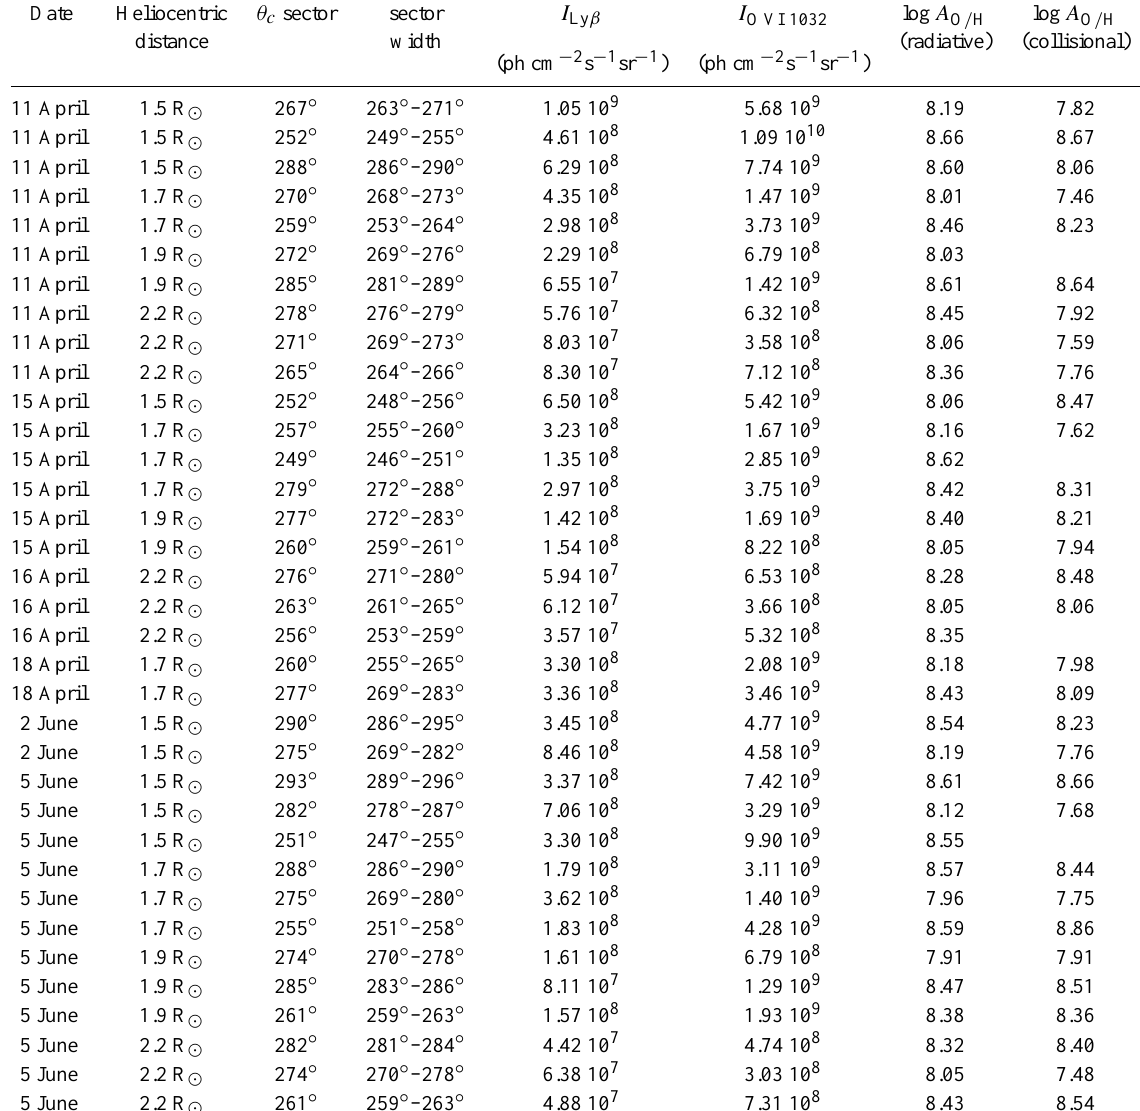
Table 2. H I Ly α and O VI 1032 Intensities and Oxygen Abundance in Selected Portions of Solar Minimum Quiescent